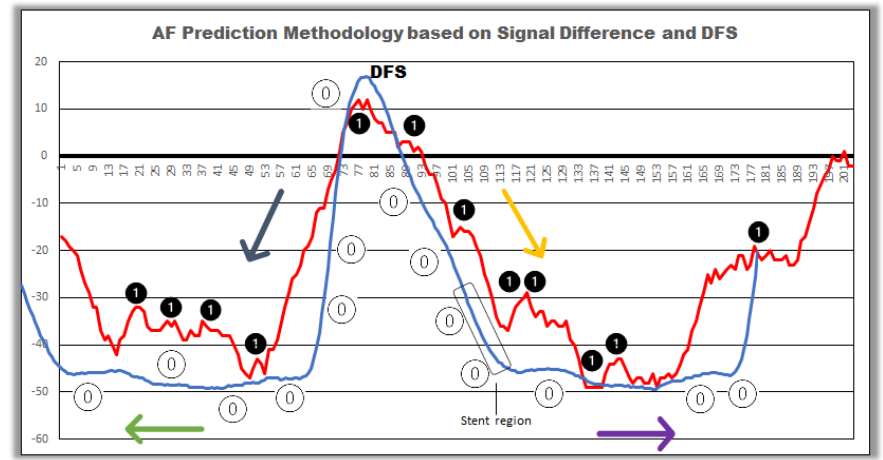
Figure 5. Atrial Fibrillation Prediction using Signal Difference and DFS.